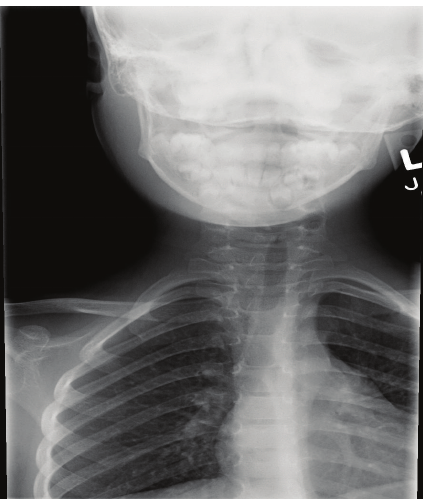
Figure 1: Soft tissue radiograph of the neck with deviation to the left and narrowing of upper airway.